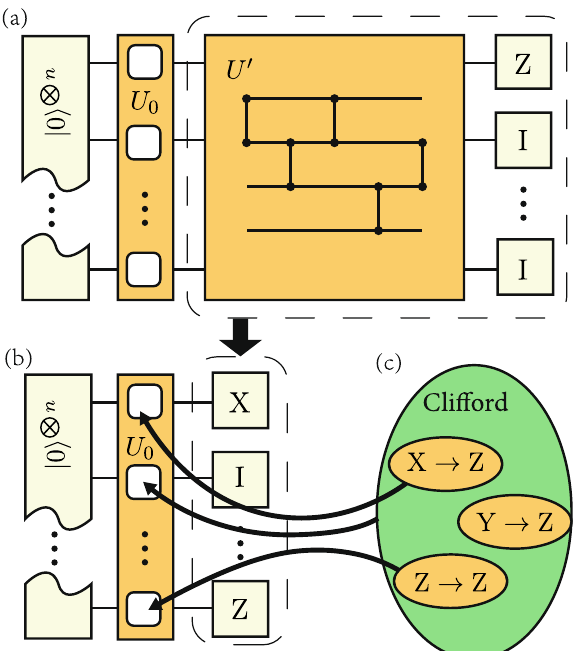
Fig. 3 Error-sensitive circuit generation. We compose an error- sensitive circuit with two sections U 0 and U 0 , as shown in ( a ). U 0 is a Clifford operator. The observable is a Pauli operator, e.g. Q = Z ⊗ I ⊗ ⋯ ⊗ I . U 0 and the observable is equivalent to an effective observable Q U 0 ¼ X (cid:2) I (cid:2) (cid:6)(cid:6)(cid:6) (cid:2) Z , as shown in ( b ). Gates in U 0 are taken from the group of single-qubit Clifford gates. We choose the gates such that all non-identity Pauli operators in Q U 0 are mapped to ± Z , as shown in ( c ).